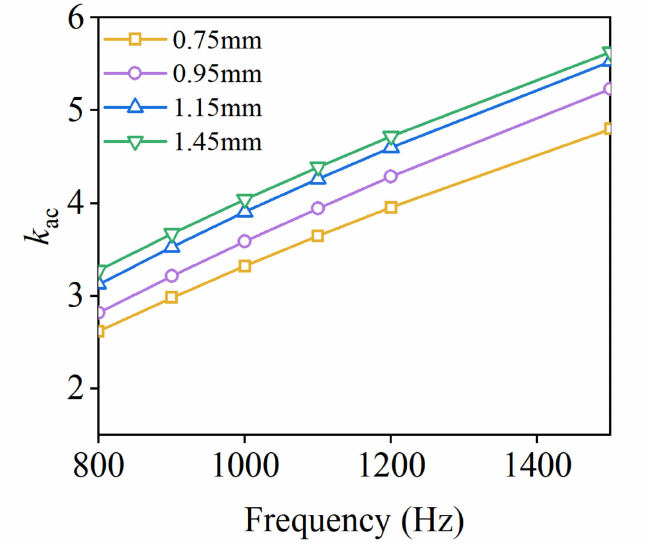
Figure 13. AC/DC copper loss ratio k ac with conductor diameter at different frequencies for Case